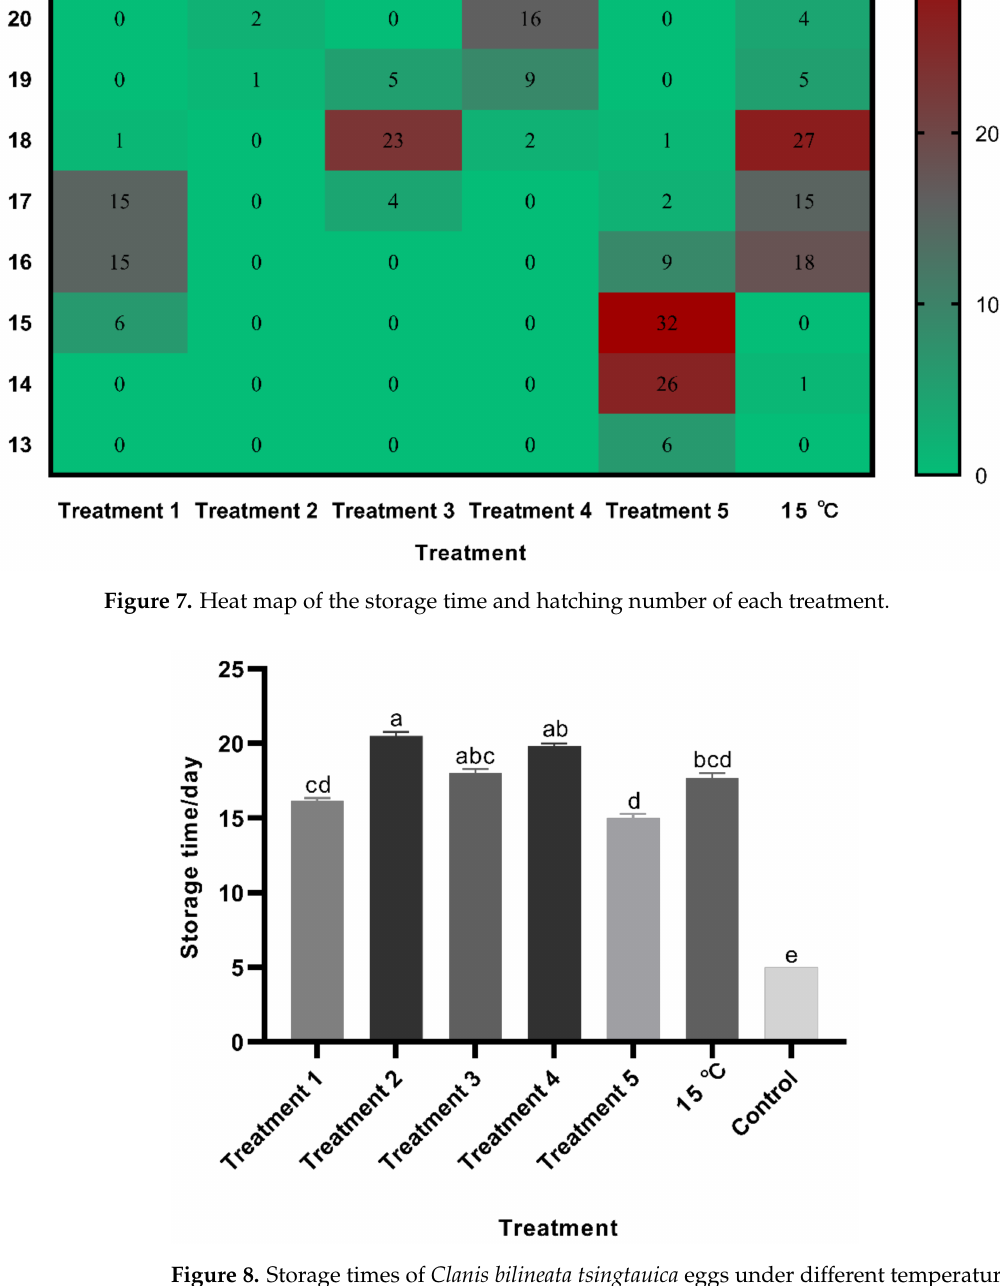
Figure 8. Storage times of Clanis bilineata tsingtauica eggs under different temperature regimes. Bars represent the standard error. Dunnett T3 was used to analyze the storage time of eggs stored at 15 ◦ C and variable temperatures. Different letters on the bars indicate significant differences ( F 6,14 = 366.58, p <